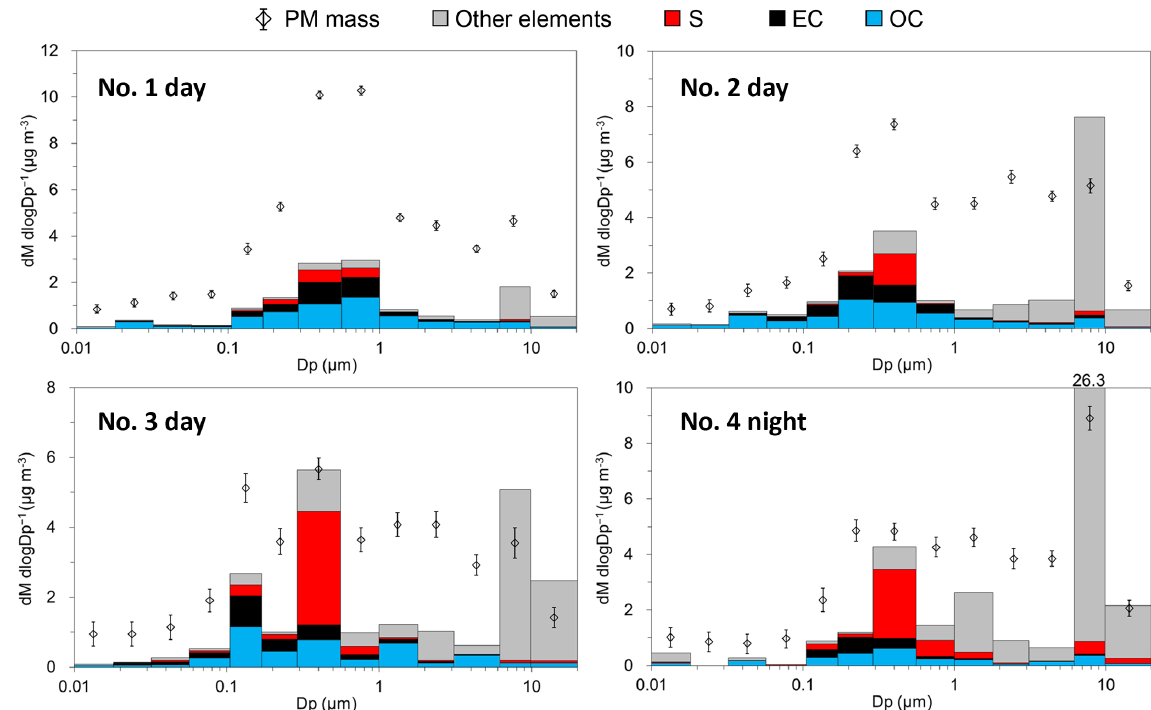
Figure 4. Mass concentrations of particles, OC, EC, sulfur, and other elements by particle size. The data of sulfur and other elements were